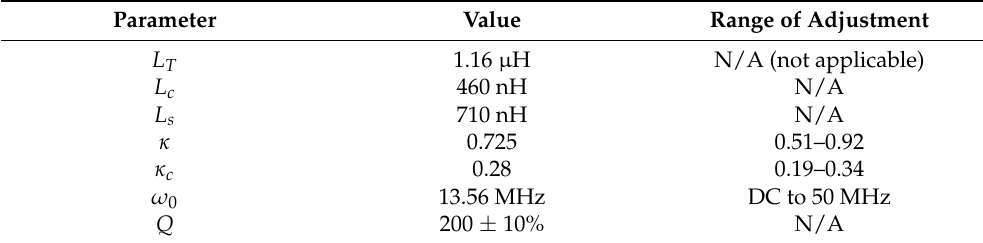
Table 1. Experimental parameter